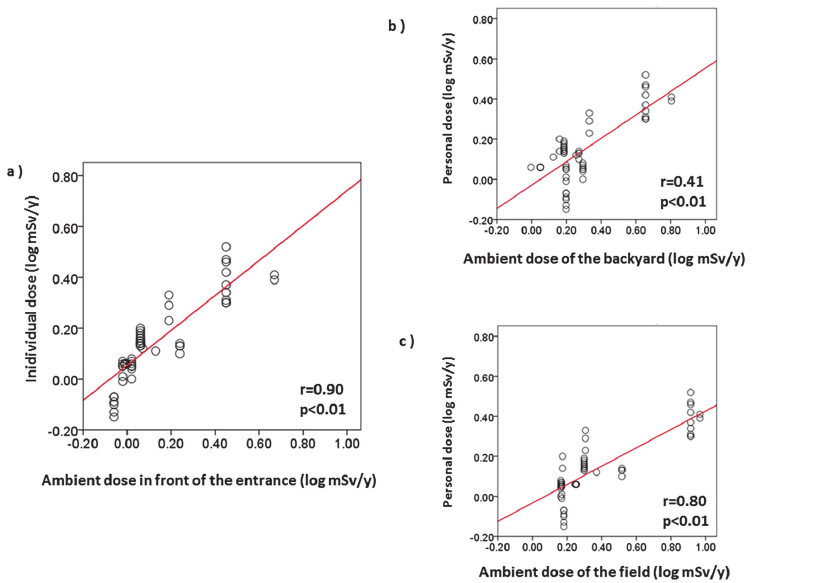
Fig 3. Relationship between individual doses and cumulative ambient doses.